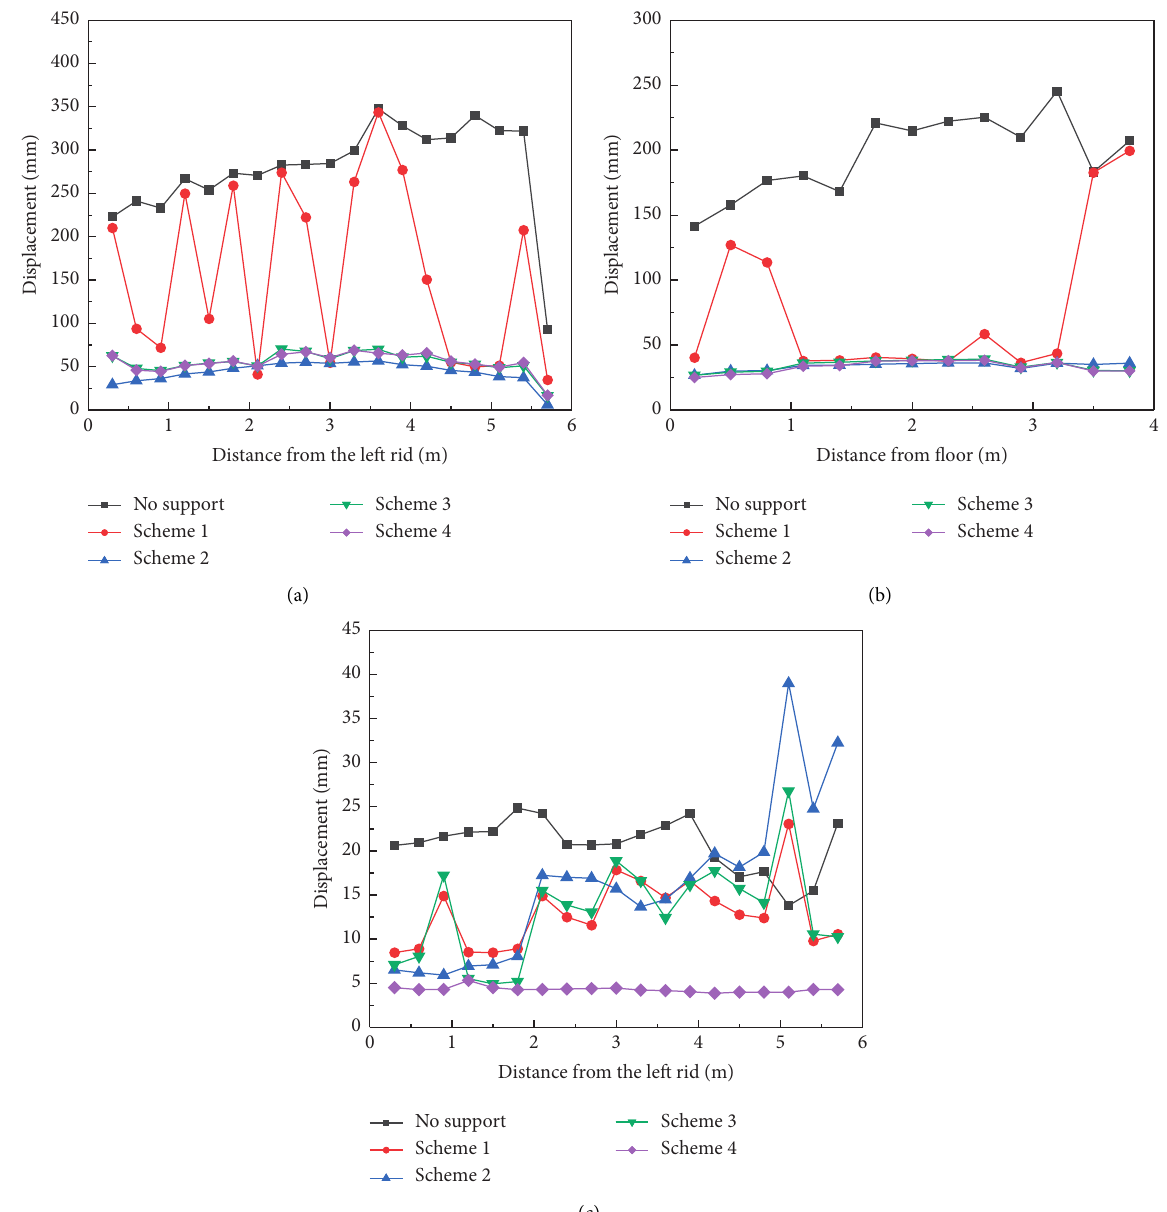
Figure 16: Displacement of roadway with different support schemes. (a) Roof. (b) Rib. (c)